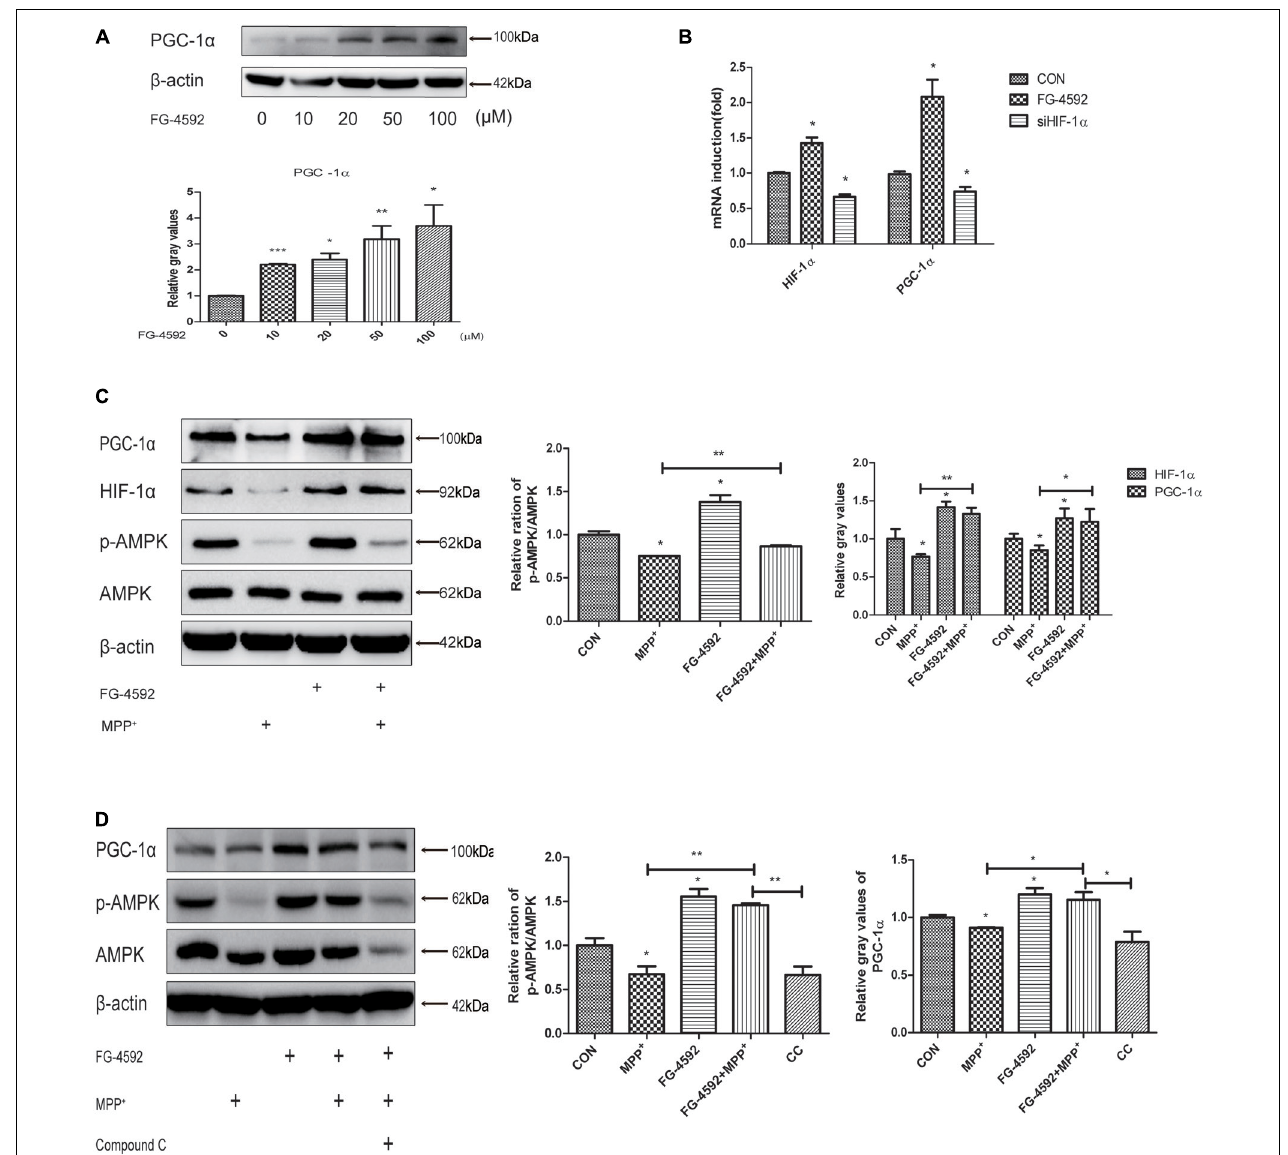
FIGURE 5 | FG-4592 increases the expression of PGC-1 α in human dopaminergic neurons. SH-SY5Y cells were treated with FG-4592 at various concentrations for 24 h. The protein level of PGC-1 α were determined by immunoblotting assay (A) . The mRNA level of PGC-1 α were determined by qRT-PCR (B) . Then SH-SY5Y cells were exposed to MPP + (3.5 mM) in the presence or absence of FG-4592 (50 µ M). The protein level of PGC-1 α , p-AMPK and AMPK were determined by immunoblotting assay (C) . SH-SY5Y cells were exposed to MPP + (3.5 mM) in the presence or absence of FG-4592 (50 µ M) and Compound C (10 µ M) for 24 h. Western blotting analysis and quantification of the relative PGC-1 α , p-AMPK and AMPK protein abundance in the cells. β -protein served as the control (D) . CC represents cells that were co-treated with MPP + , FG-4592 and Compound C. Data were expressed as mean ± SD, ∗ P < 0.05, ∗∗ P < 0.01, ∗∗∗ P < 0.001 as compared to the control or MPP + ( n =